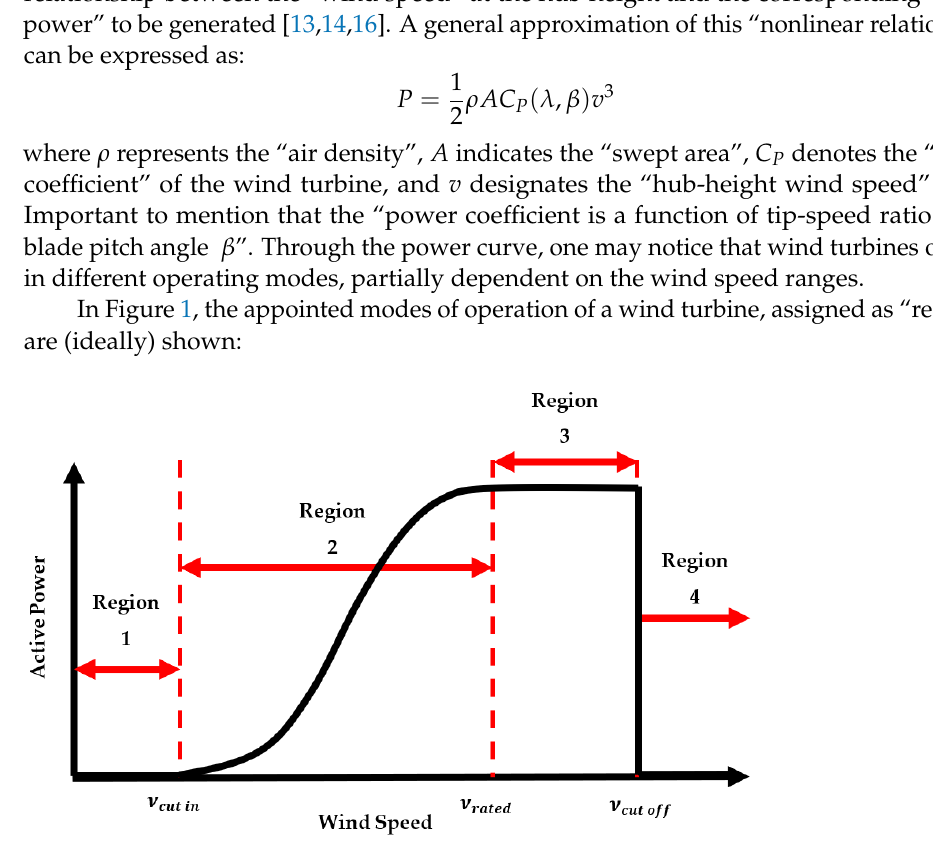
Figure 1. The ideal power curve of the wind turbine and appointed modes of operation.